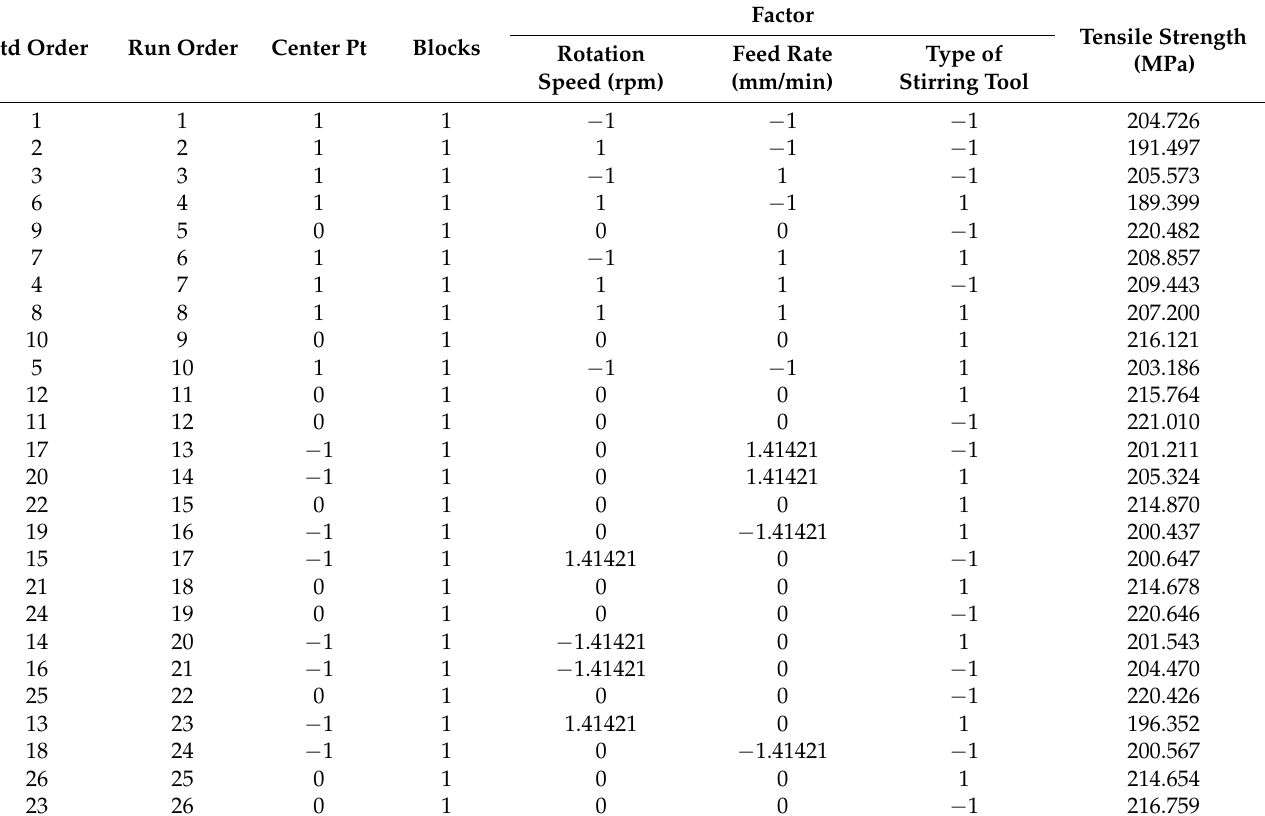
Table 5. Tensile strength test of friction stir welding workpiece.